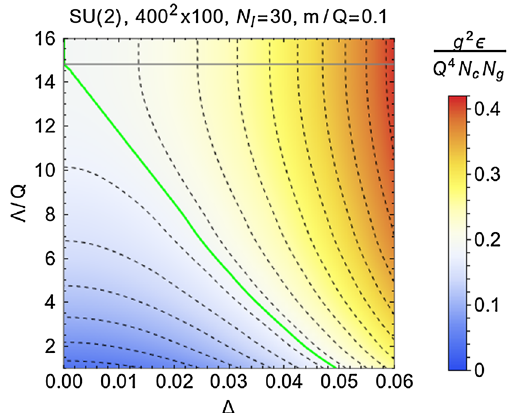
Fig. 13 Total energy density for different fluctuation seeds Δ and dif- ferent UV cutoffs Λ/ Q at initial time. The dashed lines represent con- stant energy density levels in multiples of 0 . 025. The solid green line corresponds to the energy density obtained without an additional UV cutoff and no fluctuations, i.e. Δ = 0. The horizontal grey line repre- sents the lattice cutoff above which the additional cutoff Λ no longer affects the